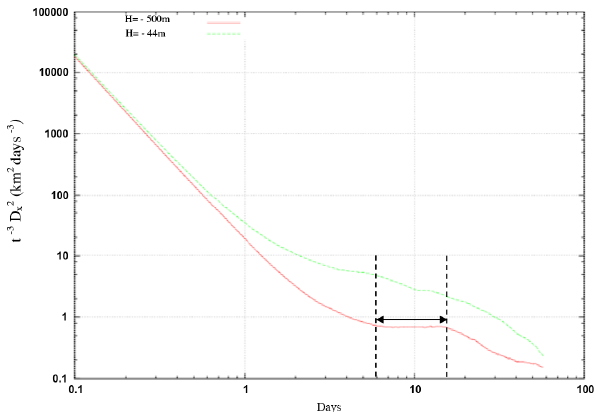
Fig. 8. The surface (green curve) and the 500m depth (red curve) relative zonal dispersion divided by t 3 for D 0 = 5 . 55km. The plateau of the 500m depth extends from the sixth to the sixteenth